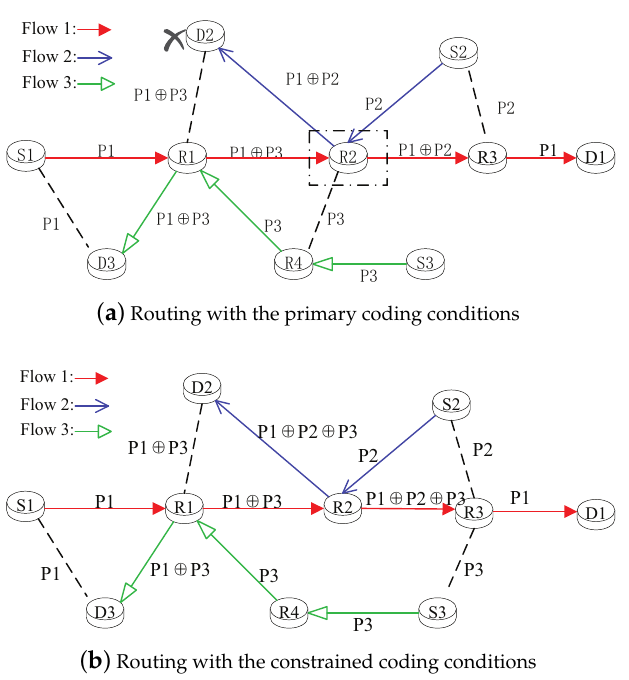
Figure 3. The routing decision with different coding conditions in a multi-flow